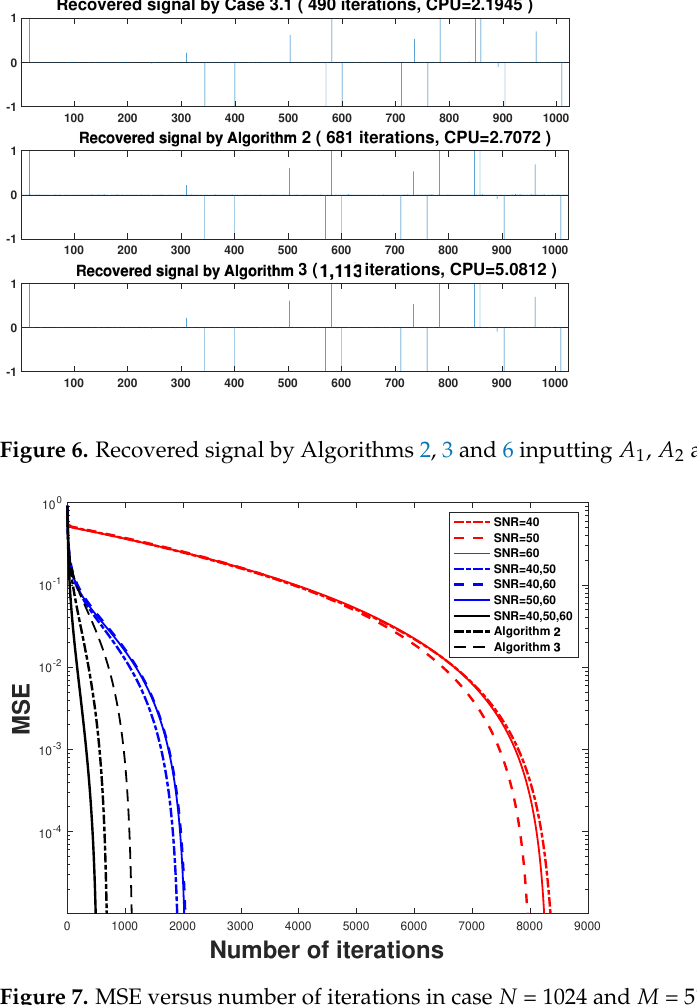
Figure 7. MSE versus number of iterations in case N = 1024 and M = 512.